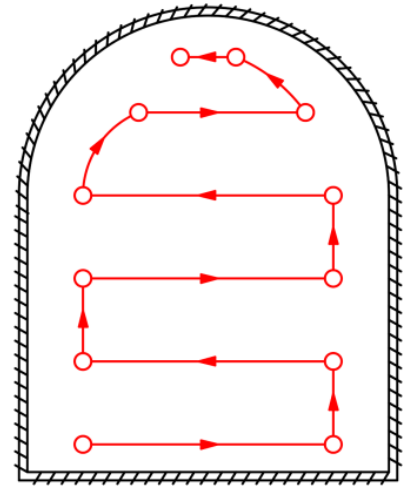
Figure 3. The cutting path of the cutting head.